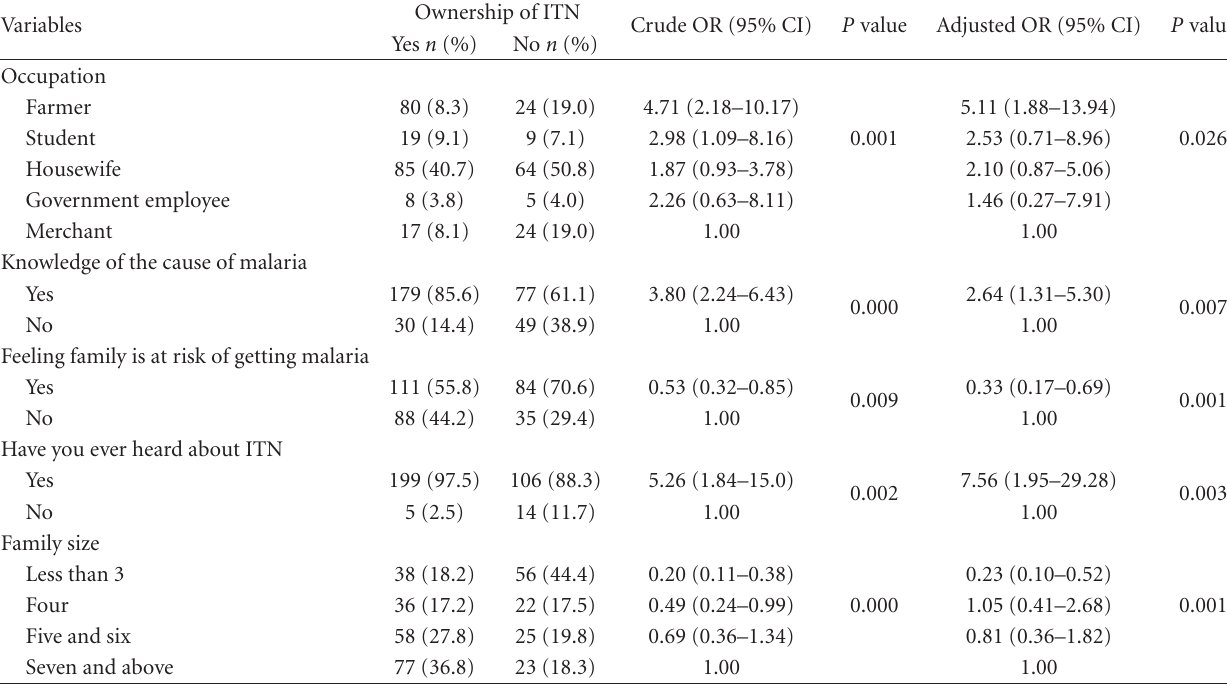
Table 4: Final logistic regression model for household’s ownership of ITNs (with estimated odds ratios) in Gursum district, Ethiopia, 2008. Variables